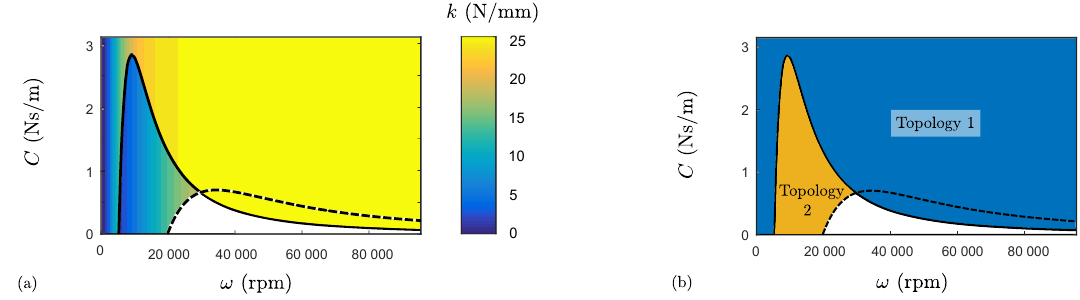
Figure 11. Comparison of the stiffness of Topologies 1 and 2 while taking into account their stability boundaries (solid and dashed lines respectively): ( a ) maximal stiffness with the spin speed; and ( b ) the corresponding